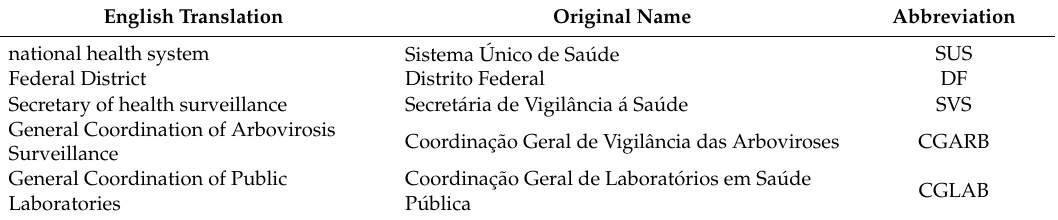
Table A2. List of Portuguese names. To facilitate the reading of the paper, several names have been translated from Portuguese to English. The original names and o ffi cial abbreviations are listed below, in order of